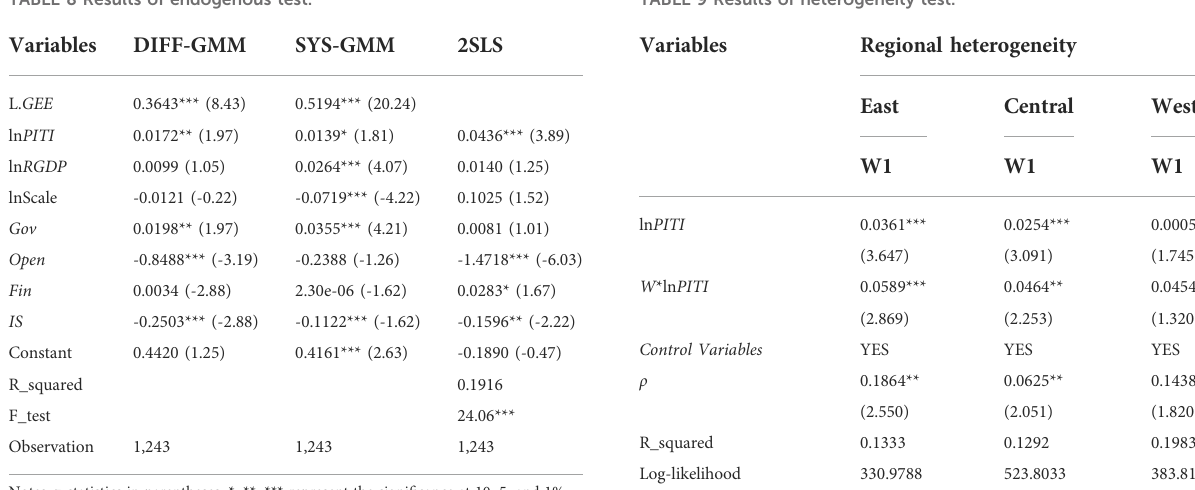
TABLE 8 Results of endogenous test. TABLE 9 Results of heterogeneity